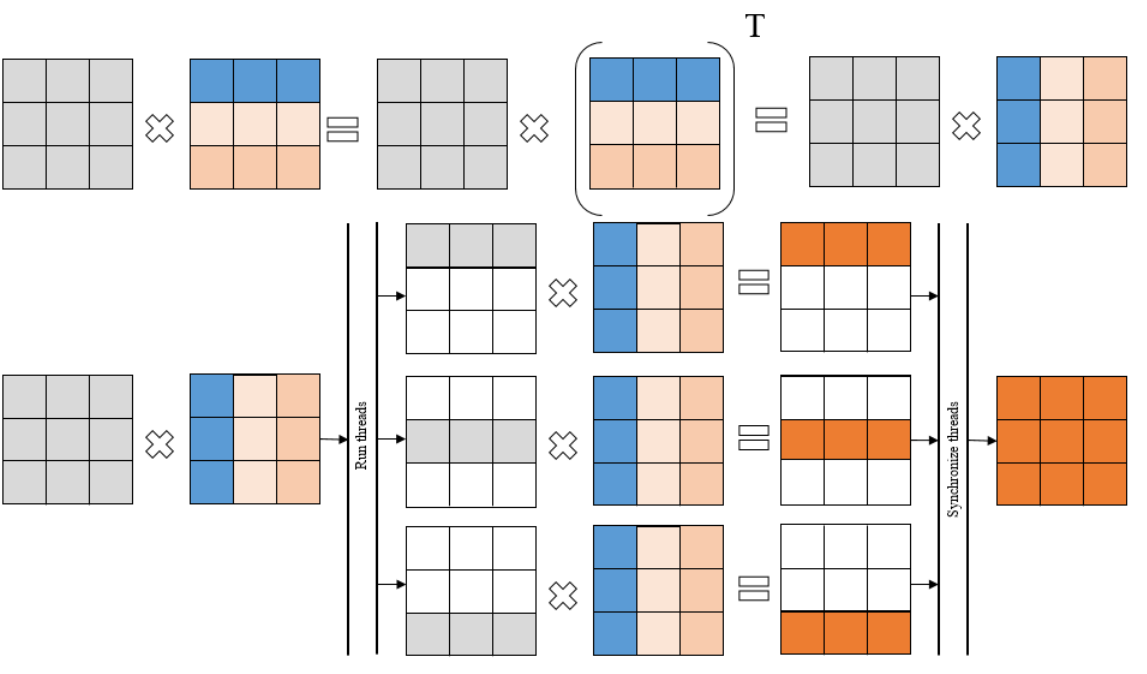
Figure 4. Matrix multiplication: CUDA implementation. Parts of the input and output matrices processed by CUDA threads are given in different colors.